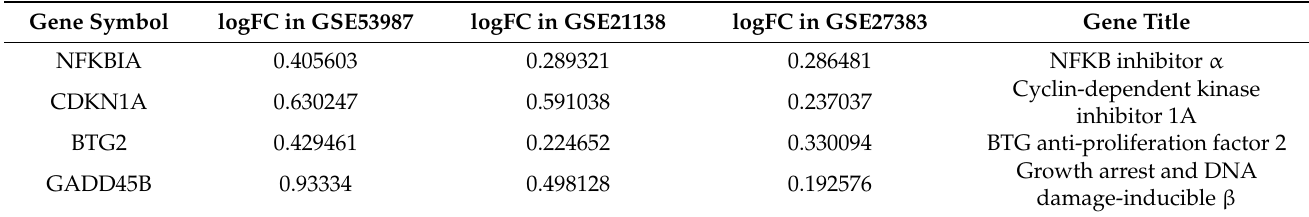
Table 2. Results obtained by taking the intersection of the CytoHubba and MCODE.